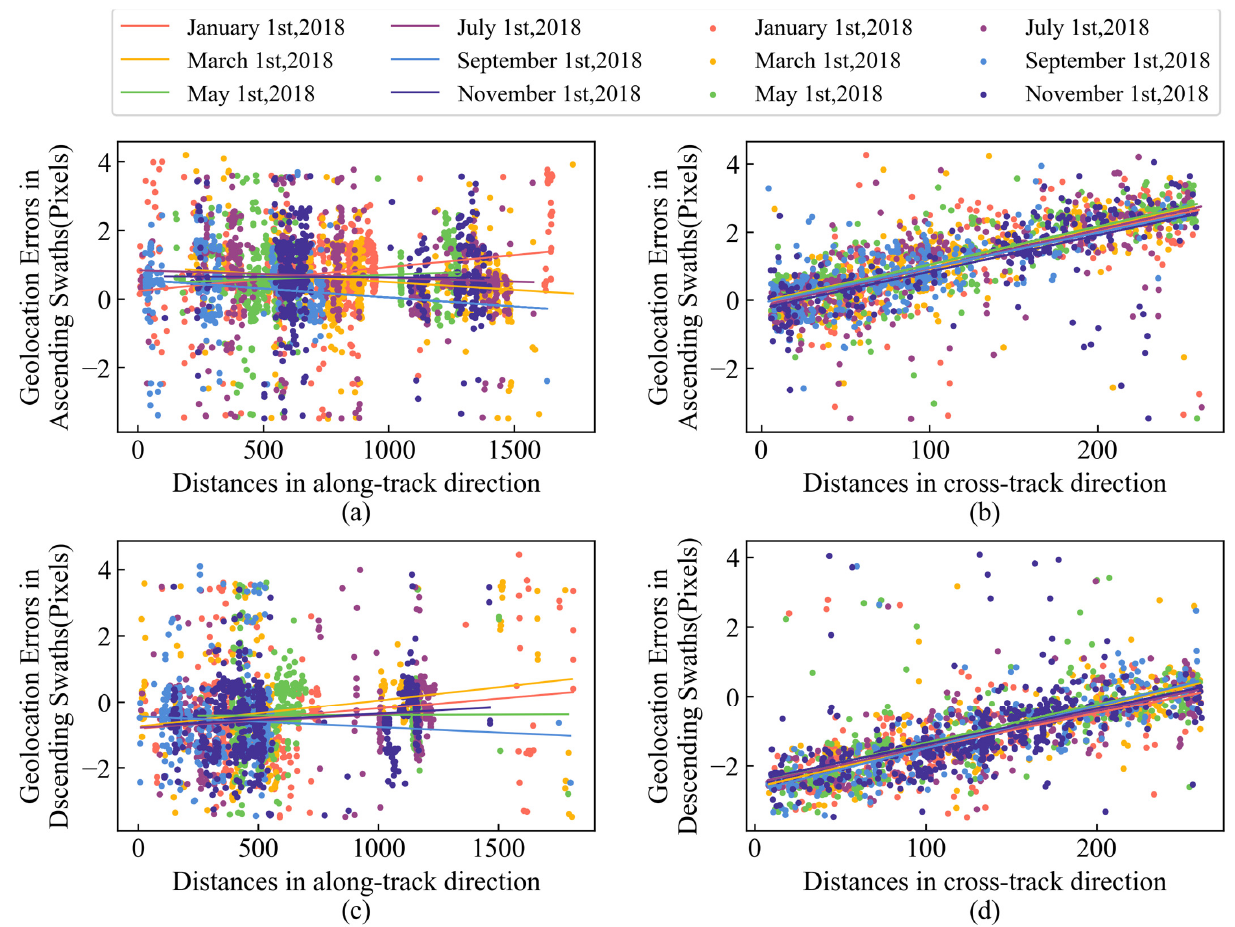
Figure 6. Geolocation errors of the coastline pixels found by SCIM for ascending ( a , b ) and descending ( c , d ) images on different dates. Horizontal axis are distances from the pixels to the scan line and the scan position in the cross ‐ track and the along ‐ track direction ( 𝒅 𝒊 , 𝒋𝐚 and 𝒅 𝒊 , 𝒋𝐜 ). Colored scatters are geolocation errors. Different colors represent different dates. The colored lines are linear fits between the geolocation errors and the distances. All distances (x axes, all diagrams) and geolocation errors (y axes, all diagrams) are given in pixels. Table 1. The correlation coefficients of the geolocation errors 𝑒 (cid:3036) , (cid:3037)(cid:3028) , 𝑒 (cid:3036) , (cid:3037)(cid:3030) and the distance 𝑑 (cid:3036) , (cid:3037)(cid:2911) , 𝑑 (cid:3036) , (cid:3037)(cid:2913) in the along ‐ track and cross ‐ track direction. Each line represents the analysis of one full half orbit starting at the indicated UTC time.